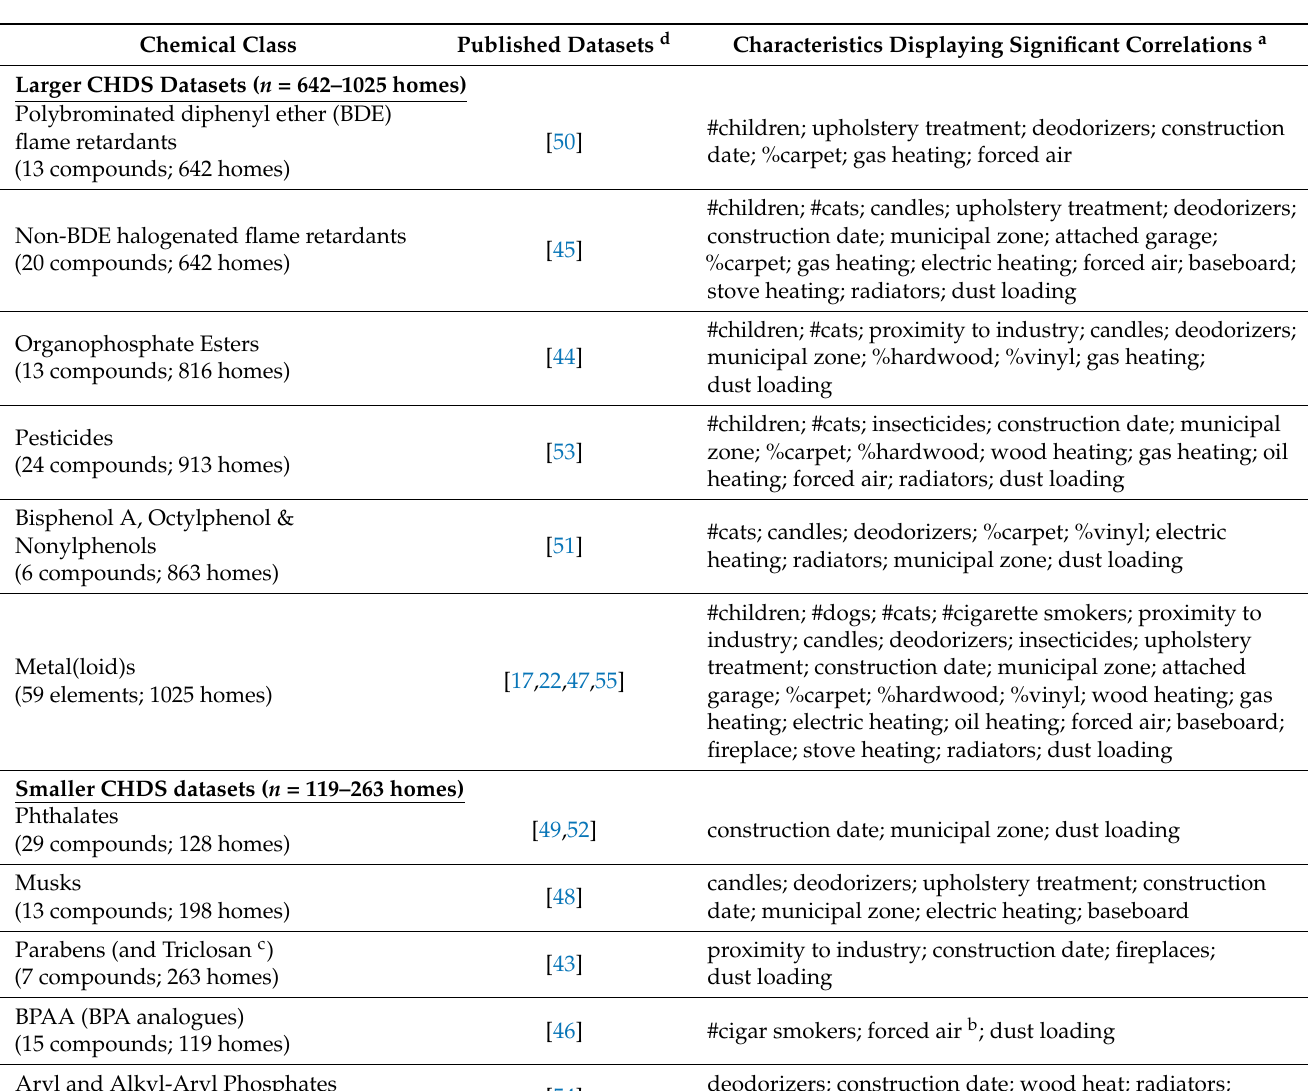
Table 2. Significant correlations a between chemical concentrations in house dust and house char- acteristics, according to classes of chemicals determined in the Canadian House Dust Study (based on Spearman rho and p values listed in SI-1 and SI-2). Correlations may be positive or negative for construction date, municipal zone, and dust